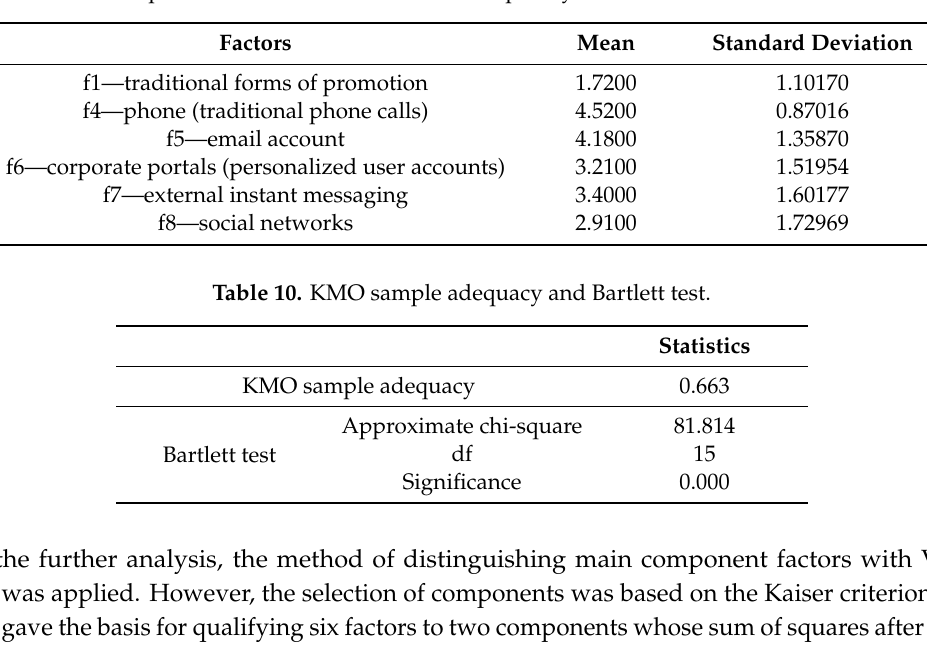
Table 9. Descriptive statistics for factors of the complexity of communication with customers.